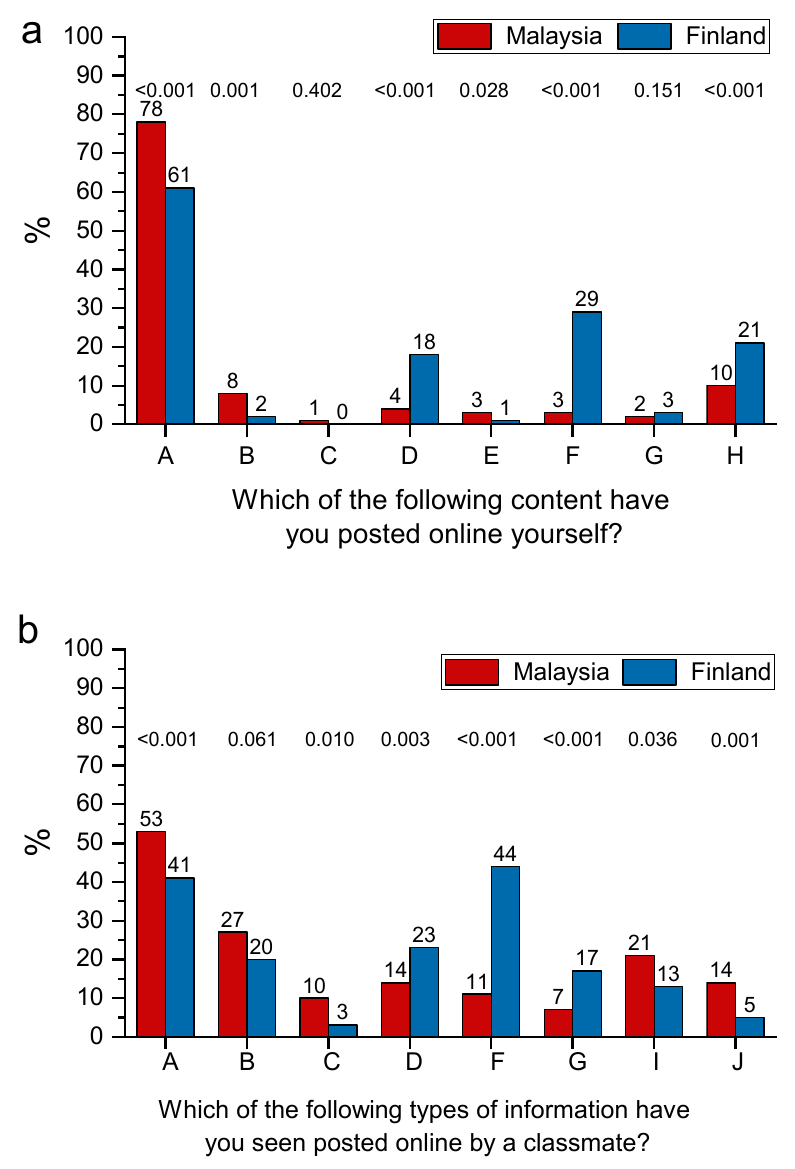
Figure 1. Percentage distributions of responses to the questions “Which of the following content have you posted online yourself?” ( a ) and “Which of the following types of information have you seen posted online by a classmate?” ( b ) by country. The contents are as follows: A = None, B = Unidentifiable patient information, C = Identifiable patient information, D = Obscene language, E = Discriminatory language, F = Depiction of intoxication, G = Sexually suggestive material, H = Items I thought were initially appropriate, but for various reasons later took down, I = Items I found objectionable but did not discuss with my classmate, J = Items I found objectionable and did discuss with my classmate. Data include dental undergraduate students from Malaysia (n = 440) and Finland (n = 203). Statistical significances between countries were evaluated by chi-square test. Table 2 shows the distribution of measures taken by the students if they had found information that they believe should not be publicly available. Malaysian students reacted more strongly to such a situation compared to Finnish dental students. In generally, stu ‐ dents reported that they had stopped “following” people (47.3% of all respondents) or removed their own names from photos that were tagged to identify them (54.0%).